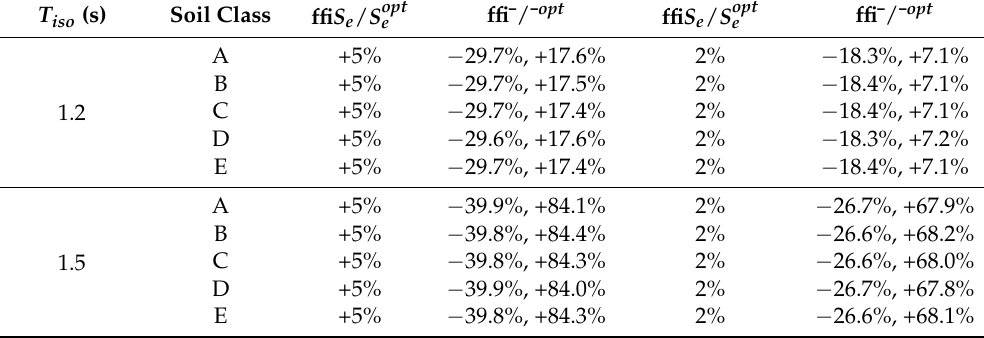
Figure 20. Sensitivity of deviation in friction coefficient from its optimum value on relative increase of structural acceleration for ( a ) T iso = 2.4 s and ( b ) T iso = 2.7 s and spectrum of type 2 with soil class C. Table 2. Sensitivity results for spectrum of type 2 for relative increase of +5% and +2% in structural acceleration.